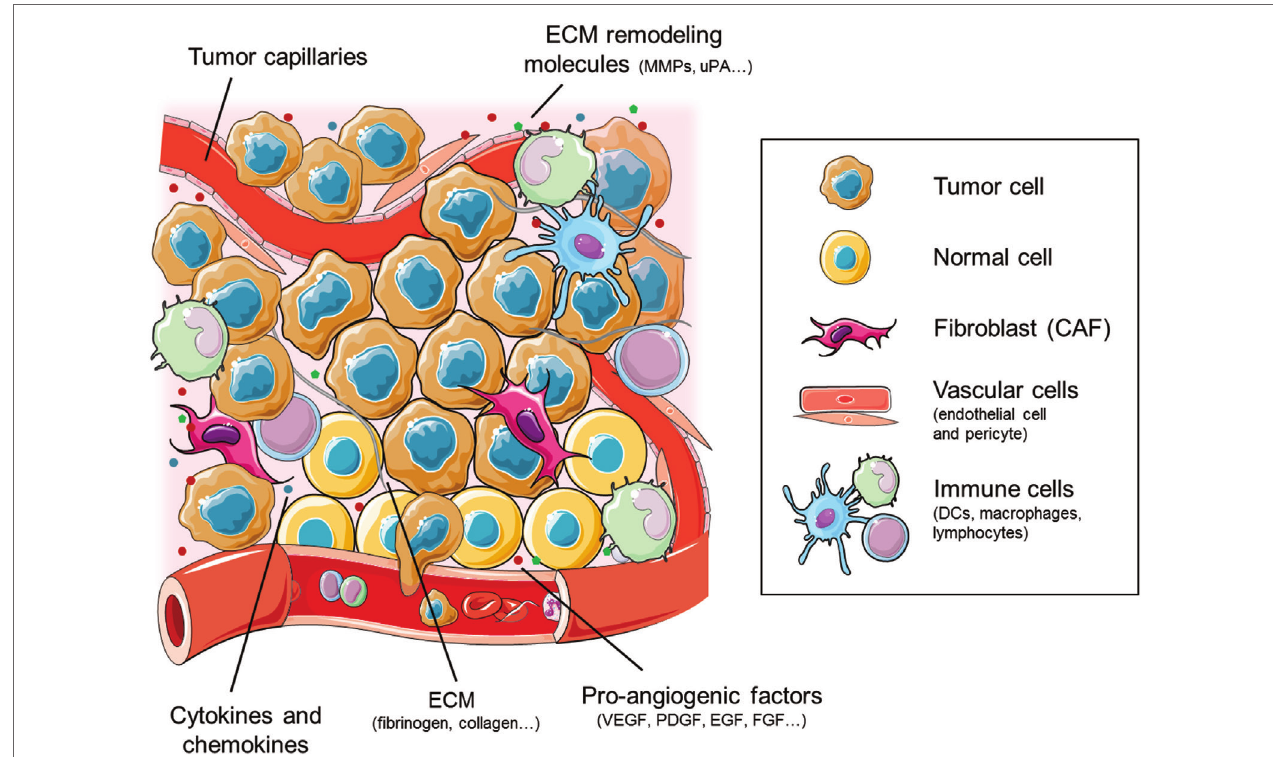
FigURe 1 | Cellular and molecular components of the tumor ecosystem that shape the tumor angiogenic landscape. The cellular components primarily consist of tumor and normal cells, together with the vascular endothelial and pericyte cells and the stromal fibroblasts [cancer-associated fibroblasts (CAFs)]. The immune cell compartment comprises mainly tumor-infiltrating macrophages, dendritic cells (DCs), and lymphocytes. Figure was created using Servier Medical Art according to a Creative Commons Attribution 3.0 Unported License guidelines 3.0 (https://creativecommons.org/licenses/by/3.0/). Simplification and color changes were made to the original